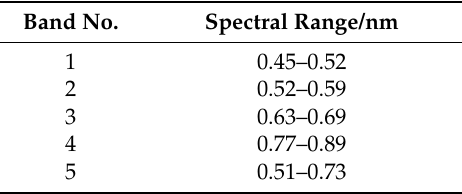
Table 2. The 5 wavebands of a CBERS-02B CCD image.